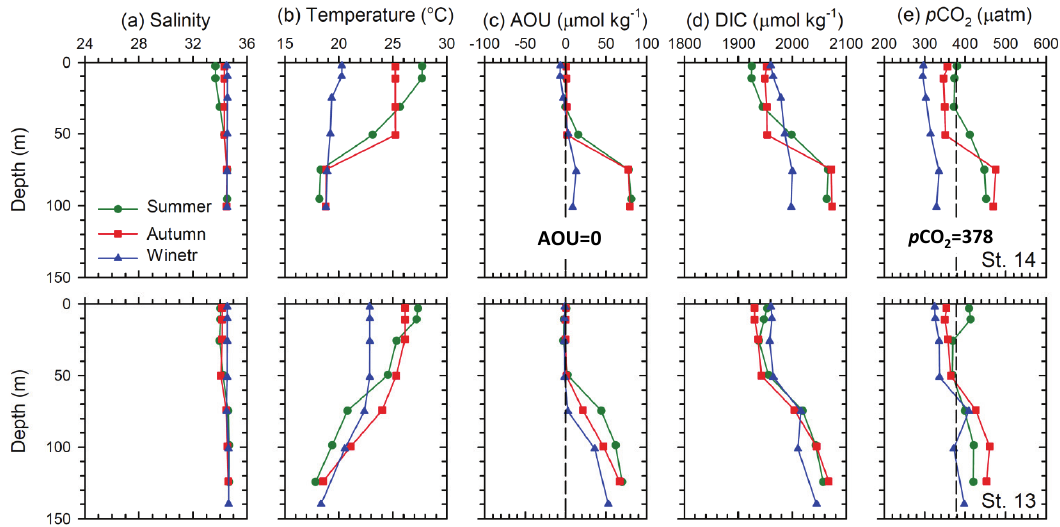
Fig. 4. Depth distributions of (a) salinity, (b) temperature, (c) AOU, (d) DIC, and (e) p CO 2 in summer, autumn, and winter at the stations with modest seasonal variations of p CO sw (stations 13 and 14 in the outer 2